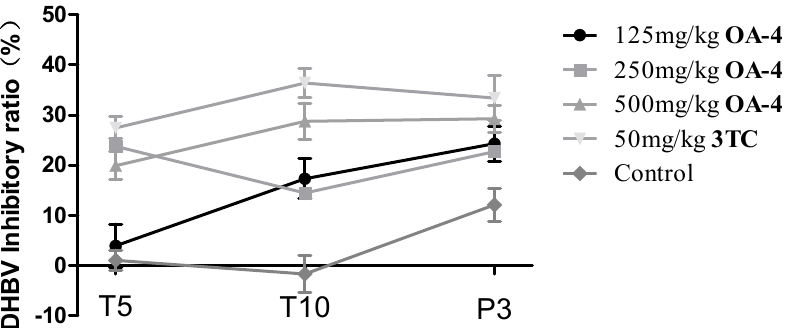
Figure 7. Inhibitory effect of OA-4 on DHBV DNA expression in duck serum at days 5, 10, and 3 after the cessation of OA-4 treatment. Data are expressed as DHBV DNA inhibitory ratio ± SD based on the independent experiments.